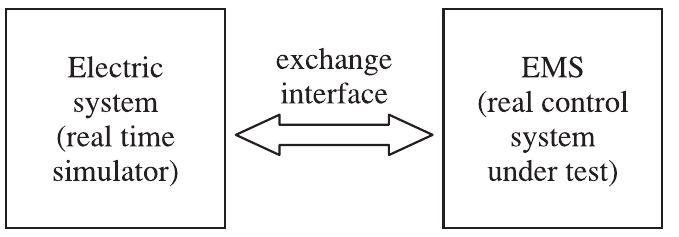
Figure 3. HIL architecture adopted in this